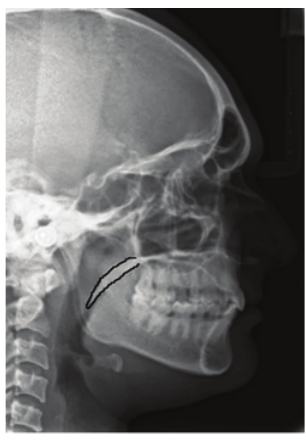
Figure4:Lateralcephalogramshowingtype4(straightline)pattern of soft palate.